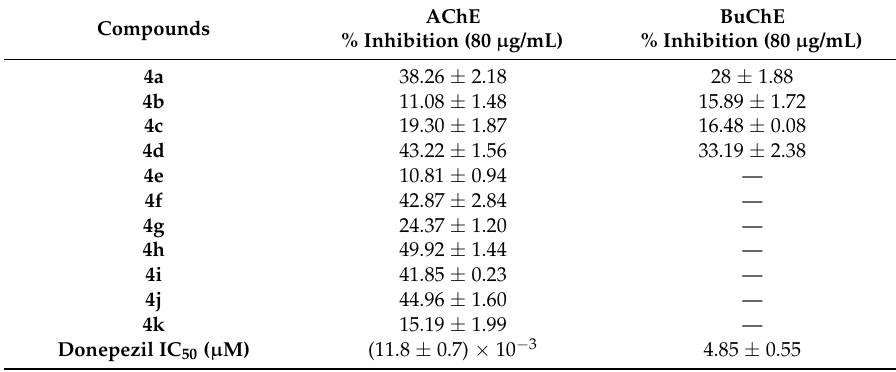
Table 4. % AChE and BuChE inhibitions of the compounds at 80 µg/mL concentration.